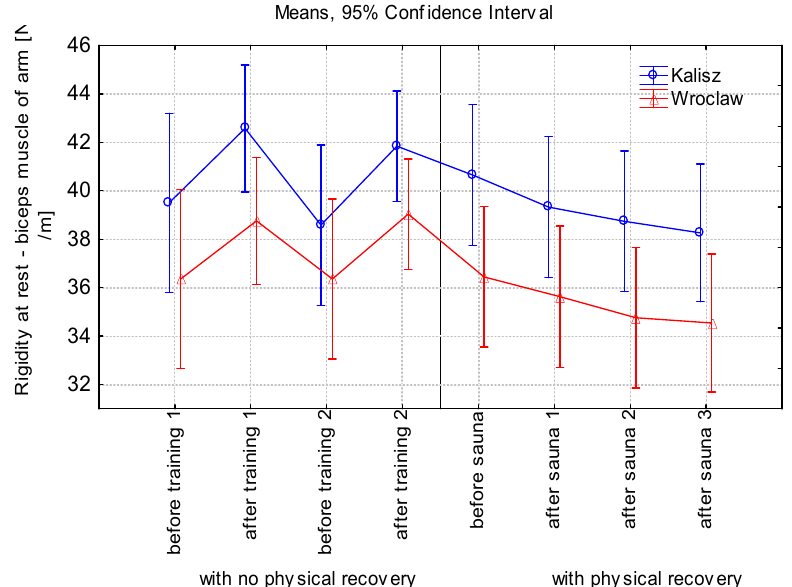
Figure 1. Stiffness differences in the biceps muscle of arm at rest for disabled swimmers in the training cycle without and with physical recovery 2 Measurements biceps stiffness at rest: F (7, 126) =, 79568, p =, 59228 According to the assessment of the central part of the deltoid muscle for both clubs swimmers, the stiffness at rest in the training mesocycle with the recovery (stage 2) is substantially reduced before and after the training, upon the exit from sauna (Table 1, 2, Fig. 2). Stiffness parameters compared before and after the mesocycle training failed to prove statistically significant differences for the Kalisz swimmers while in case of Wroclaw competitors notable changes were recorded.